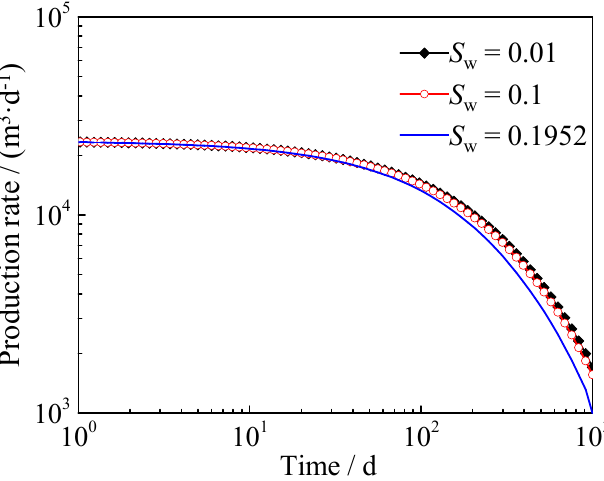
Figure 9. Influence of water saturation on gas flow rate in shale gas reservoirs with ultra-low water saturation.